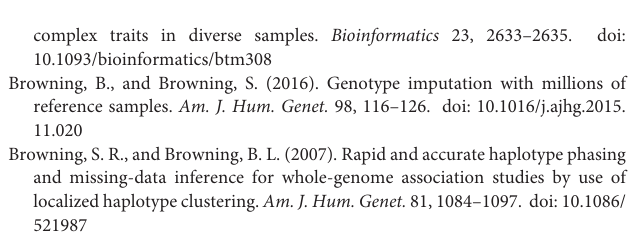
FIGURE S1 | GO analysis of interactive genes with selected genes in A54 and B154. Histogram showing the significantly functional distribution of interactive genes with selected genes in A54 and B154, respectively. The scale bar represents the significant levels. FIGURE S2 | Data distribution and correlation analysis of eight traits. ∗ , ∗∗ , and ∗∗∗ indicate a significant correlation at P < 0.05, P < 0.01, and P < 0.001 respectively. FIGURE S3 | QQ-plots of eight ear related traits in two locations. QQ-plot of EL in E1 (A) and E2 (E) . QQ-plot of FL in E1 (B) and E2 (F) . QQ-plot of BTL in E1 (C) and E2 (G) . QQ-plot of SR in E1 (D) and E2 (H) . TABLE S1 | The material information of AM208. TABLE S2 | The list of selective regions and genes in A54 and B154, respectively. TABLE S3 | GO enrichment analysis of selected genes from Shaan A and B groups. TABLE S4 | Interaction between selected genes and other genes. TABLE S5 | GO enrichment analysis of interactive genes of selected genes. TABLE S6 | Results of genome-wide association study for EL, FL, BTL, and SR in two environments. TABLE S7 | Haplotype effect of three significant SNPs related to EL and FL. TABLE S8 | Functional enrichment analysis of key genes regulating EL and FL. TABLE S9 | Common selected genes in maize domestication and improvement processes compared to previous